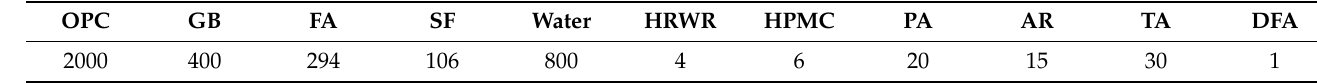
Table 1. Mix proportion of the 3D-printable material (unit: gram by